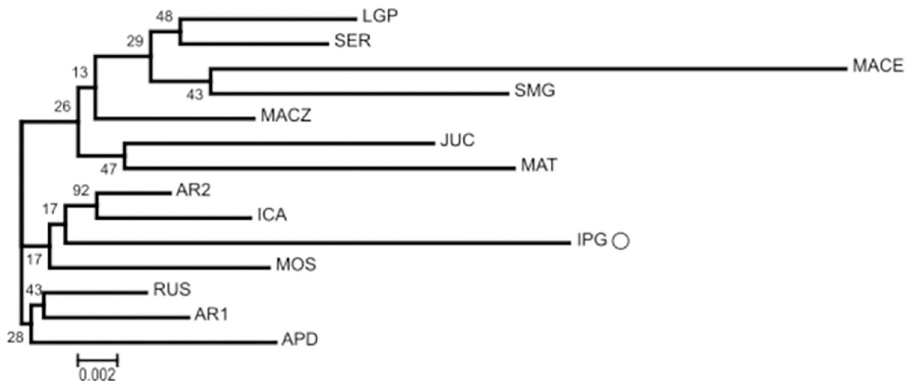
Fig 5. Dendrogram obtained by the neighbor-joining method based on SNP markers for the 14 populations of C . prunifera .